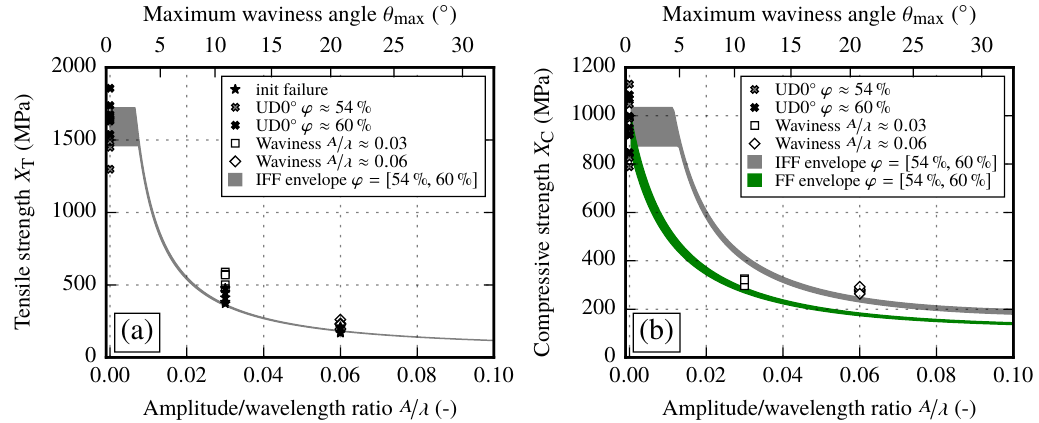
Figure 26. Comparison of the experimental results at different amplitude to wavelength ratios A / λ (or maximum waviness angle θ max ) with the analytical predictions for tensile ( a ) and compressive ( b )